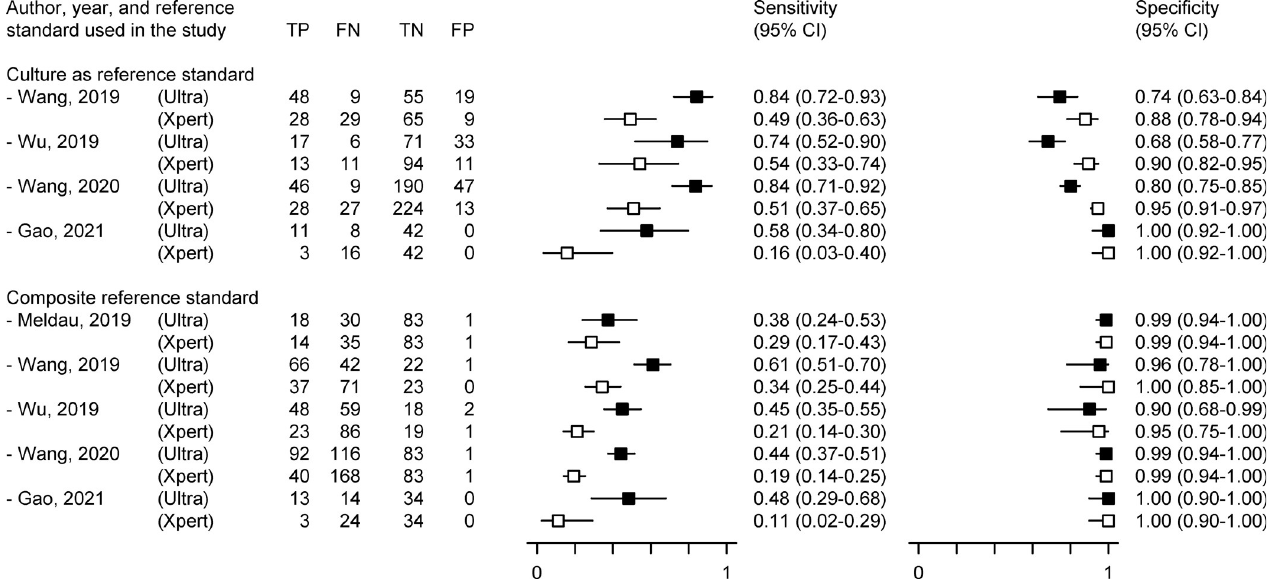
Fig 3. Coupled forest plot from studies on diagnostic accuracy of pleural fluid Xpert MTB/RIF and Xpert MTB/RIF Ultra in the same patient population. Individual sensitivity and specificity estimates for diagnosing tuberculous pleural effusion are derived from data on true positives (TP), false negatives (FN), true negatives (TN), and false positives (FP), and are represented by solid and hollow squares for Xpert MTB/RIF Ultra and Xpert MTB/RIF respectively. Horizontal lines depict 95% confidence interval.